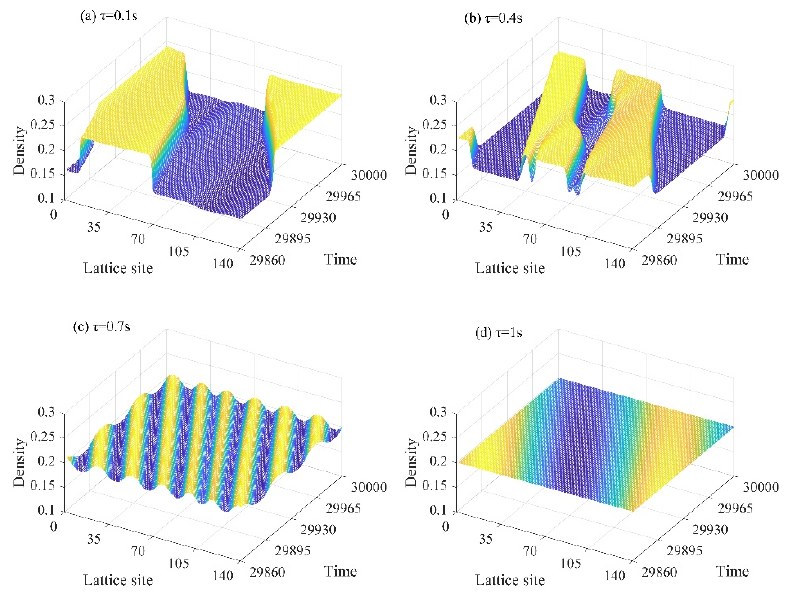
Figure 7. Space–time evolution of density under different value of parameter τ